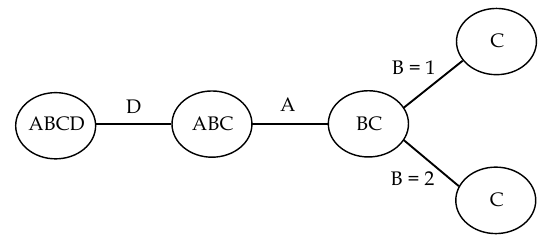
Figure A30. Tree graph for the analysis of the effect of factor C on the convergence performance.